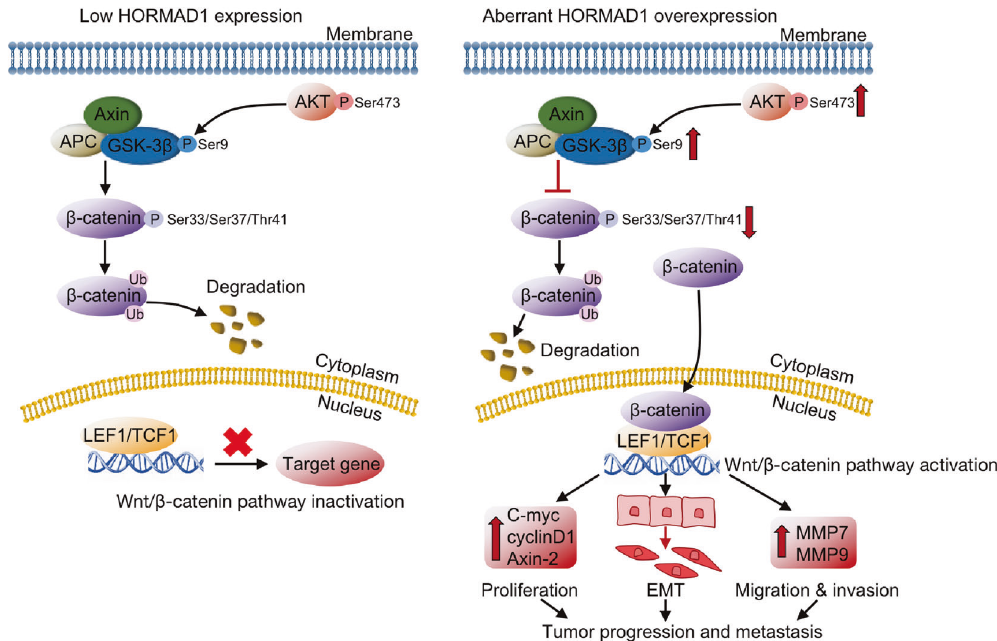
Fig. 8 Schematic model of the mechanism by which HORMAD1 functions to promote the malignant phenotypes of lung cancer cells. Aberrant HORMAD1 expression suppresses the degradation of cytosolic β -catenin and promotes nuclear β -catenin accumulation by regulating AKT/GSK-3 β signaling to activate the Wnt/ β -catenin pathway, accompanied with upregulation of downstream target genes and induction of EMT to promote tumor growth and metastasis in lung